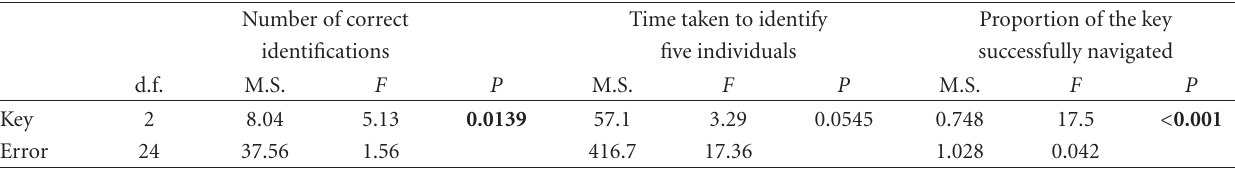
Table 3: Summary of repeated measures ANOVAs to identify di ff erences between the three keys in terms of correct identifications, time taken, and the proportion of the key navigated before a mistake was